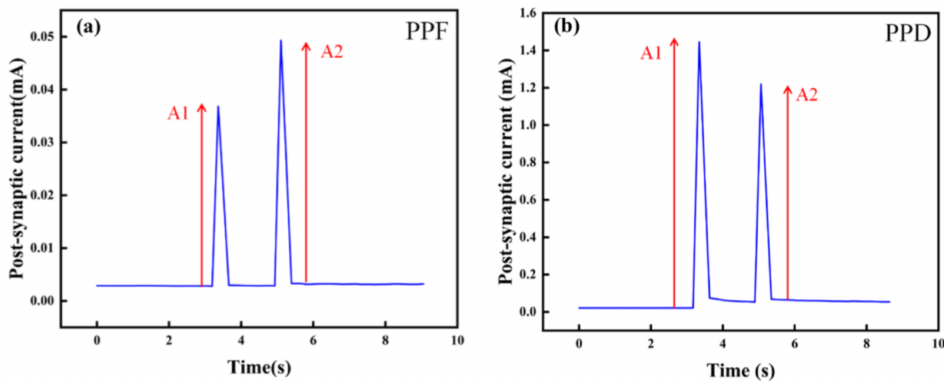
Figure 8. STSP of the Au/CsPbI 3 /ITO artificial synapse. The amplitude of pulses is 1 V. A1 is the amplitude of the PSC after the first pulse. A2 is the amplitude of the PSC after the last pulse. ( a ) PPF state in the Au/CsPbI 3 /ITO artificial synapse. ( b ) PPD state in the Au/CsPbI 3 /ITO artificial